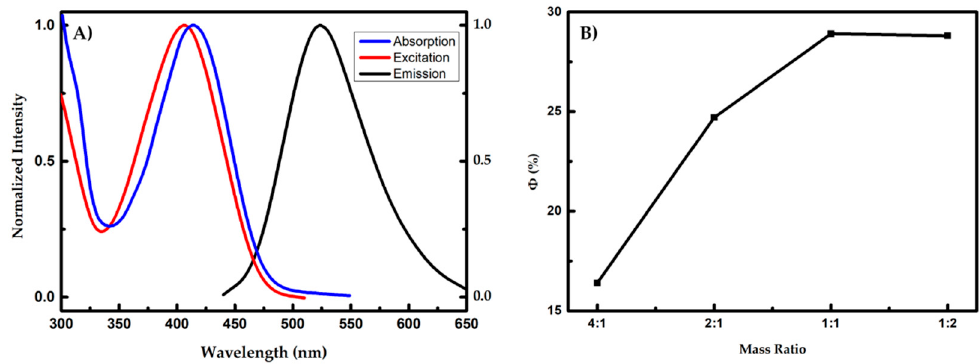
Figure 1. ( A ) Absorption, excitation, and emission spectra of AIE dots; ( B ) the fluorescence quantum yield of AIE dots as a function of the mass ratio between PSMA and DSA (PSMA:DSA = 4:1, 2:1, 1:1, 1:2).